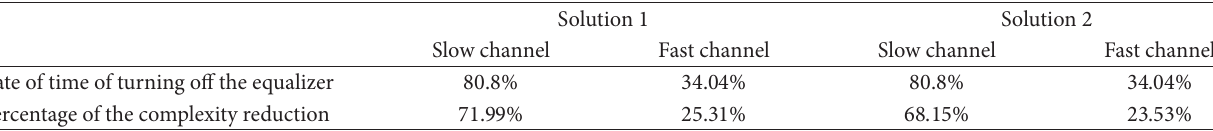
T 5: Computational complexity reduction for the rician channel.